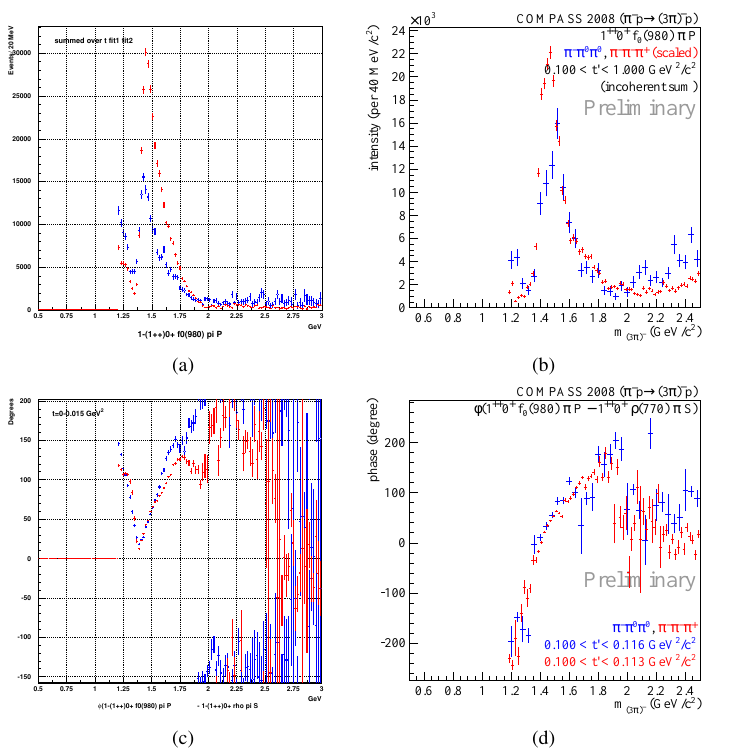
Figure 2: 1 ++ 0 + f 0 (980) π P intensity VES (a), COMPASS (b). Relative phase between the 1 ++ 0 + f 0 (980) π P and the 1 ++ 0 + ρ (770) π S VES (c), COMPASS (d). The π − π − π + data are shown in red, the π − π 0 π 0 data in